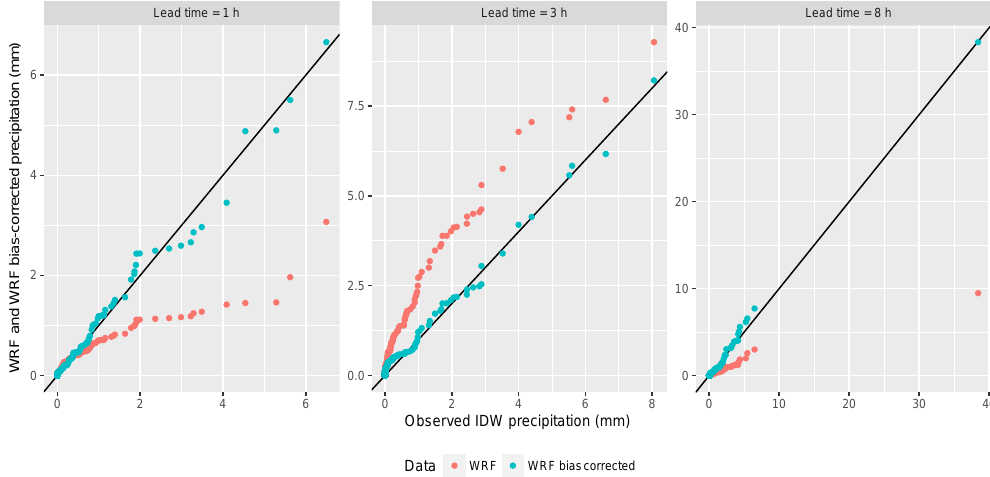
Figure 3. Q–Q plots (quantile–quantile plot, plot of the quantiles of the first data set against the quantiles of the second data set) for the Mugroso watershed comparing observed precipitation with WRF and WRF bias corrected